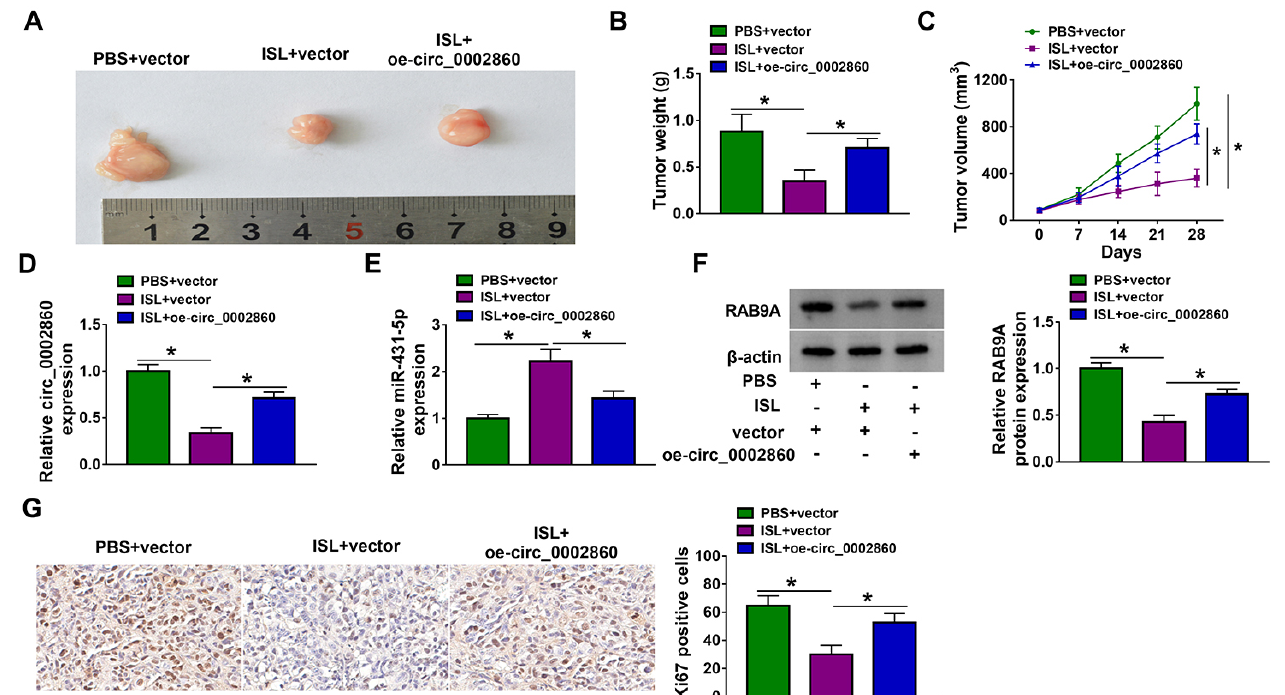
Figure 7. ISL reduced tumor growth of melanoma in vivo by targeting circ_0002860 to regulate the miR-431-5p/RAB9A axis. (A) Tumor pictures in xenograft models of PBS+vector, ISL+vector and ISL+oe-circ_0002860 groups. (B) Tumor weight and (C) volume of each group. RT-qPCR was employed for detecting the levels of (D) circ_0002860 and (E) miR-431-5p in tissues. (F) RAB9A and (G) Ki67 protein levels were measured via western blot and IHC assay,